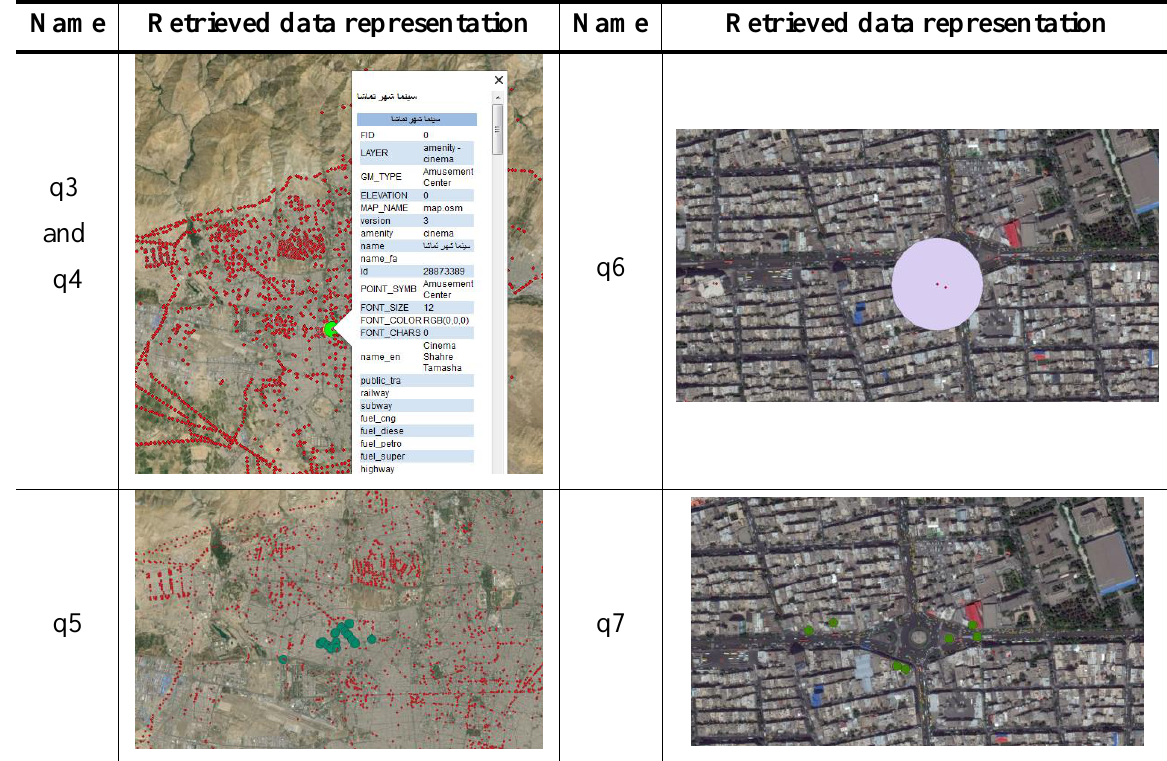
Table 3. Geographical representation of retrieved